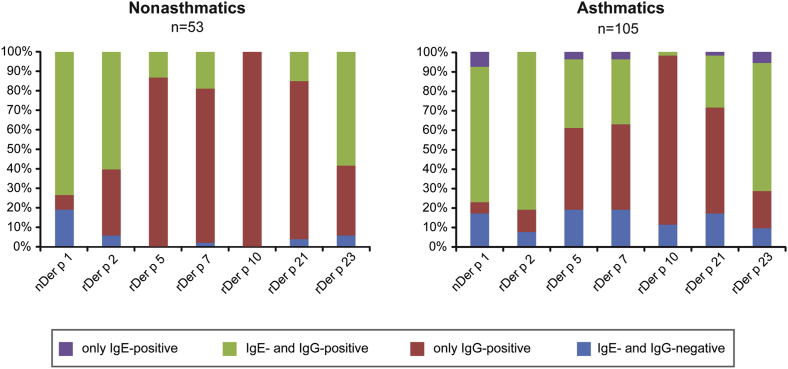
Percentages of sera with certain IgE and IgG reactivity profiles to HDM allergens. Displayed are percentages (y-axes) of sera among the group of asthmatic and nonasthmatic children with HDM allergy containing only IgE (violet), IgE and IgG (green), only IgG (red) or neither IgE nor IgG (blue) to each of the allergens (x-axes).